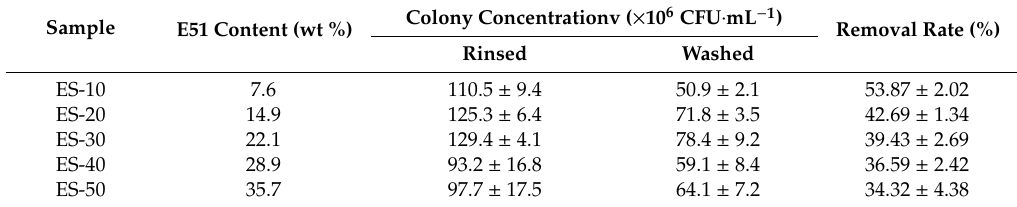
Table 6. Bacterial adhesion test results and relative adhesion force between fouling organisms and coatings.